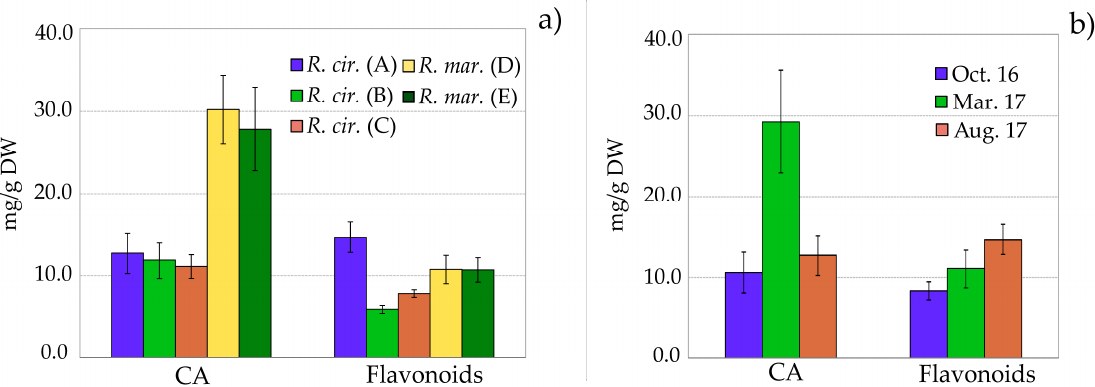
Figure 4. ( a ) Flavonoid and chicoric acid ( CA ) content in leaves of Ruppia cirrhosa ( R. cirr. ) and Ruppia maritima ( R. mar .) collected from different localities; ( b ) Flavonoid and chicoric acid ( CA ) content in leaves of Ruppia cirrhosa collected in October 2016, March 2017 and August 2017. Amounts are expressed in mg/g (mean value ± SD, n = 4) dry weight, based on quercetin 3- O - β - D -glucopyranoside (flavonoids) or caffeic acid ( CA ) equivalents.